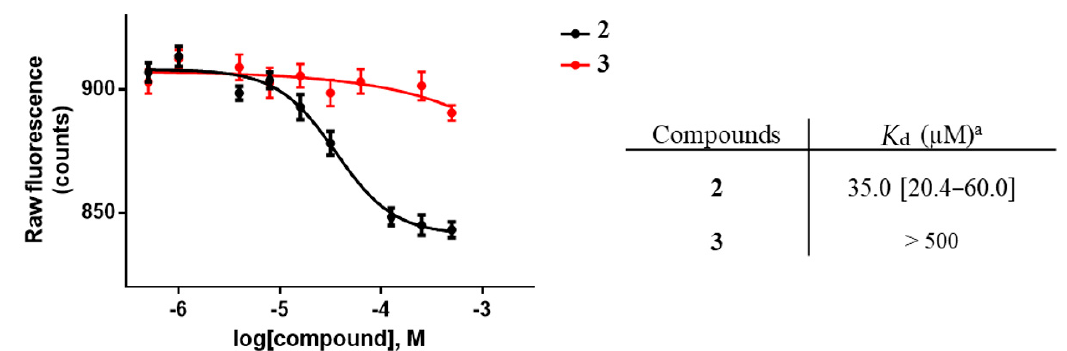
Figure 3. Measurement of binding affinity between 2 , 3 and PHGDH by MST. Dose-response curves of 2 and 3 on isolated PHGDH protein. Binding affinities ( K d ) of 2 and 3 ( K d values were determined from two independent experiments per- formed in triplicates at each compound dilution, in brackets: 95% confidence intervals).